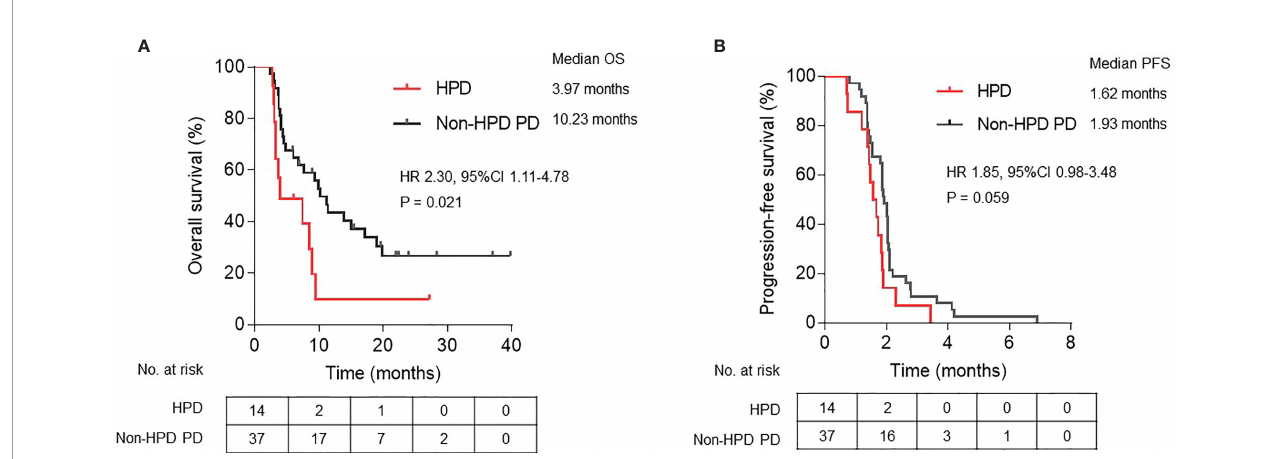
FIGURE 4 | Kaplan-Meier plots of (A) overall survival (OS) and (B) progression-free survival (PFS) in patients de fi ned as HPD compared with non-HPD progressive disease. HPD, hyperprogressive disease; PD, progressive disease; HR, hazard ratio; CI, con fi dence